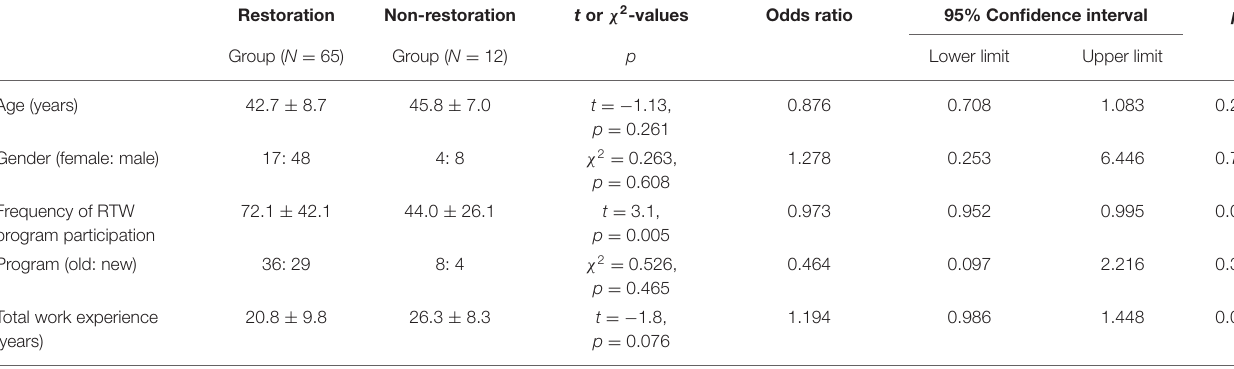
TABLE 1 | Results of t or χ 2 -test and binary logistic regression analysis of restoration and non-restoration groups. Restoration